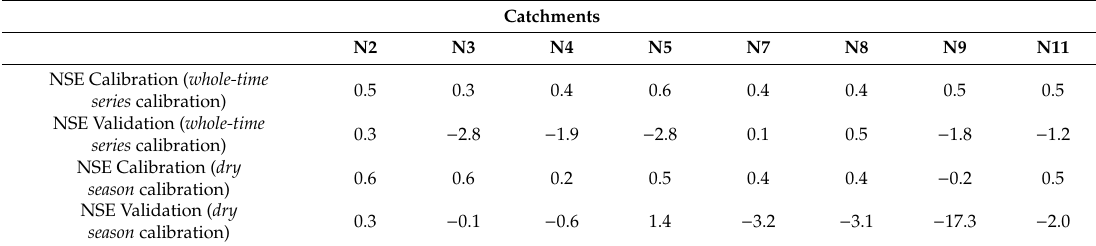
Table 3. Nash–Sutcli ff e Index (NSE) value for Calibration and